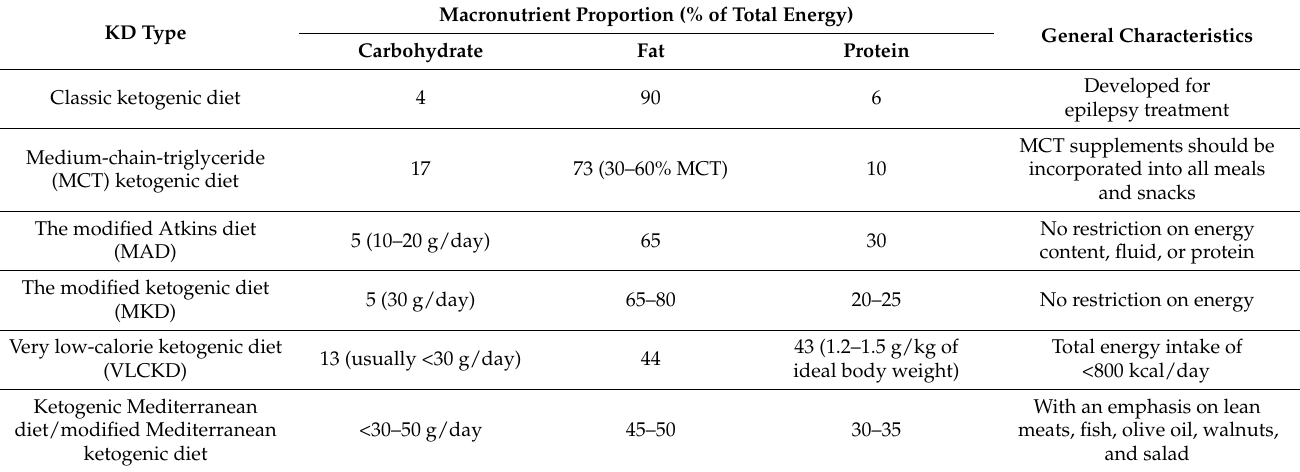
Table 1. Different types of ketogenic diet